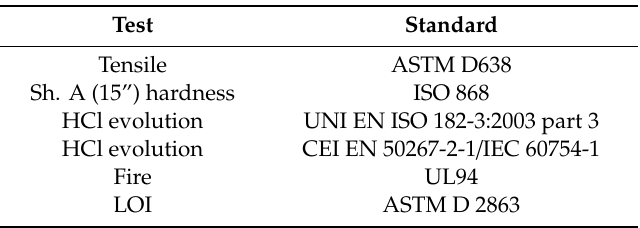
Table 4. Standard